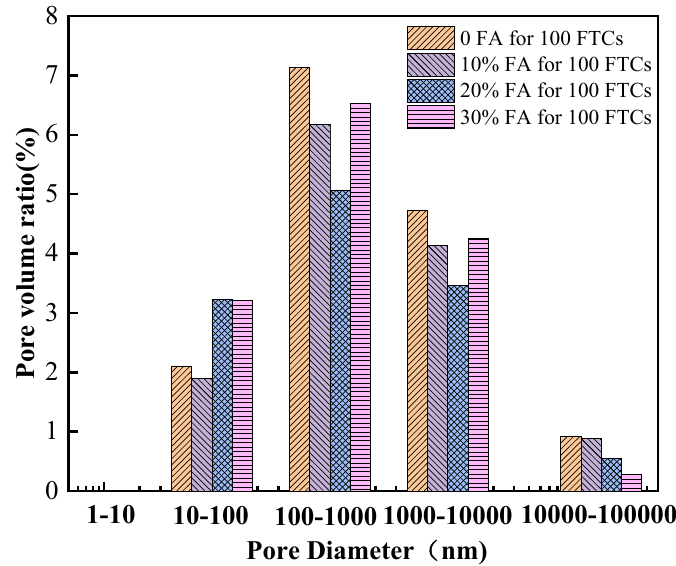
Figure 10. Pore size distribution under 100 FTCs.